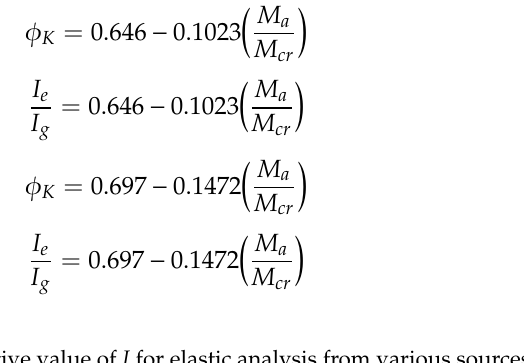
Table 9. The alternative value of I for elastic analysis from various